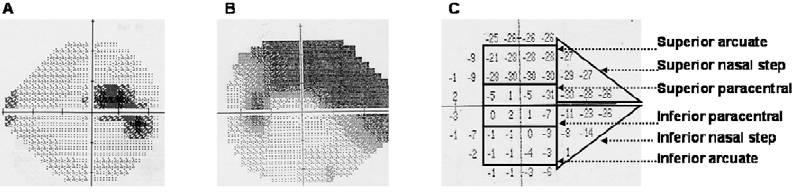
Figure 1. Visual field scoring. The average pattern standard deviation (PSD) in each of 6 regions of the visual field corresponding to the superior paracentral, inferior paracentral, superior nasal arcuate, inferior nasal arcuate, superior nasal step, and inferior nasal step were calculated for each individual. Patients were classified as having paracentral scotomas (PS) if they had a mean PSD in one of the paracentral regions greater than 5 dB and also if the mean PSD was more than 5 dB greater than any other visual field region. Patients were classified as having nasal step/arcuate scotomas (NS) if one of the four possible nasal step or arcuate regions had a mean PSD greater than 5 dB and if one of the four possible regions was 5 dB greater than either of the paracentral regions. The visual field in panel A is an example of a PS, and panel B an example of an NS visual field. The PSD plot in panel C corresponds to the visual field in panel B.